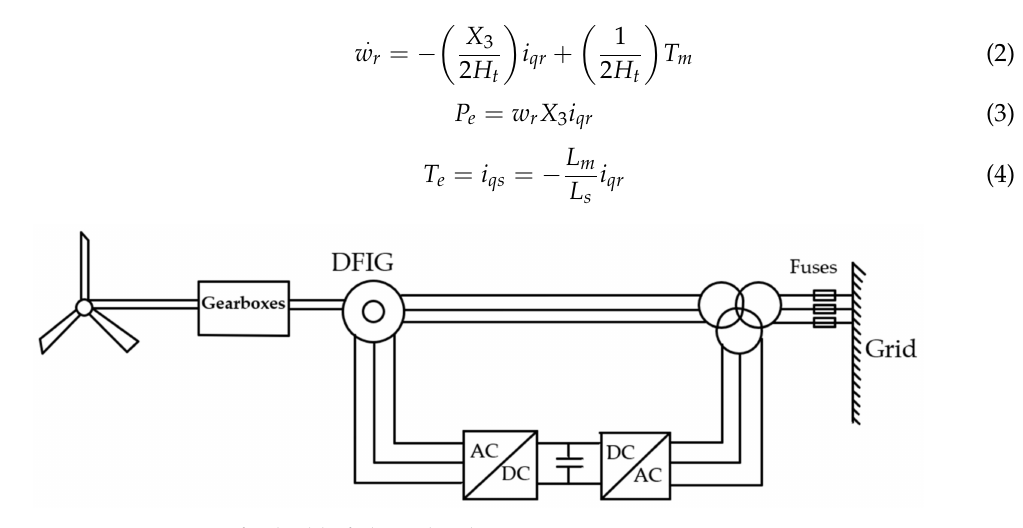
Figure 1. Structure of a doubly fed wind turbine. Table 1. Parameters of power